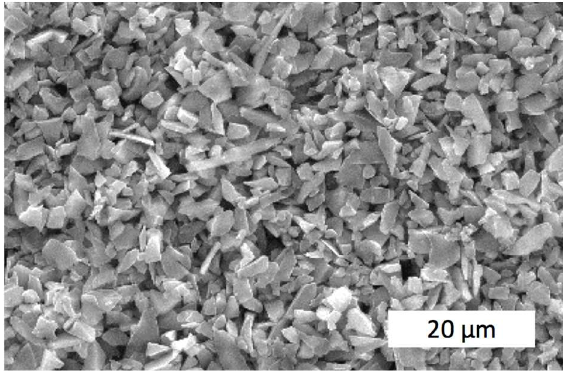
Figure 5. SEM image of nanopowders SiO 2 .